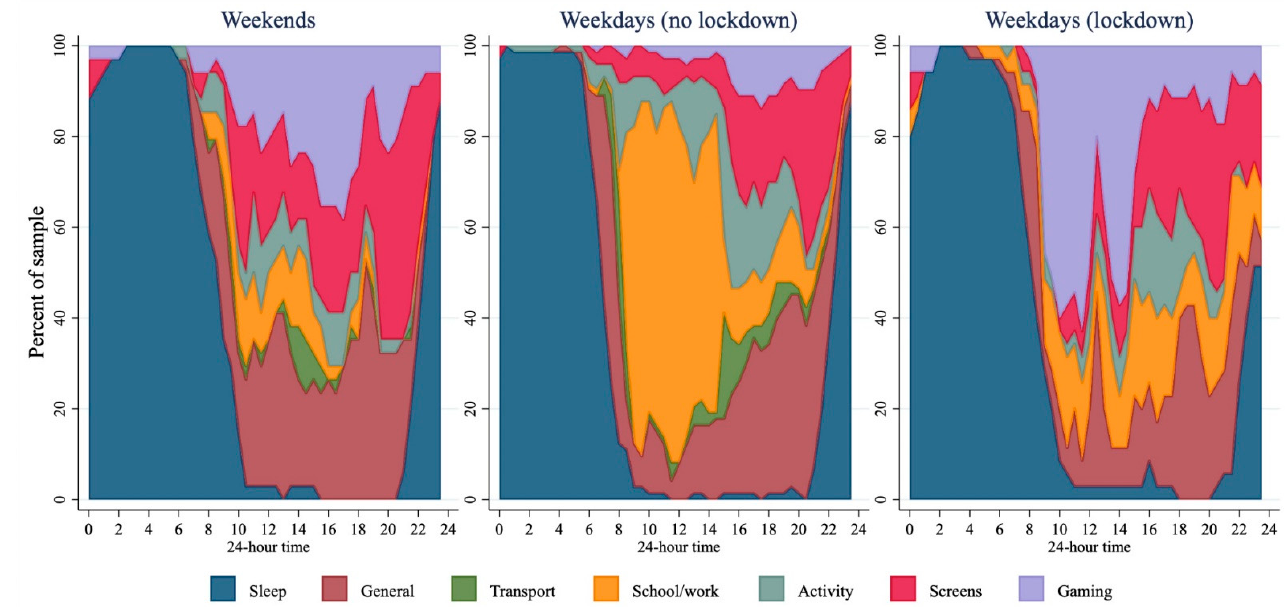
Figure 2. Activities across 24 h for weekends ( n = 34), weekdays before lockdown ( n = 73), and weekdays during lockdown ( n = 35). ‘General’ included activities of daily living; ‘Transport’ included car/bus/train/e-scooter; ‘Activity’ included active transport, PE, sport, or other physical activity; ‘Screens’ included TV, computers, phones, not including gaming; and